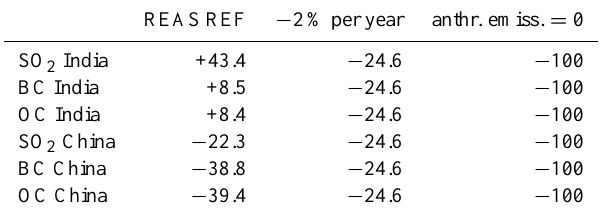
Table 1. Percentage changes of anthropogenic emissions of differ- ent aerosol species in India and China. Change from REAS 2006 prediction inventory to each of the